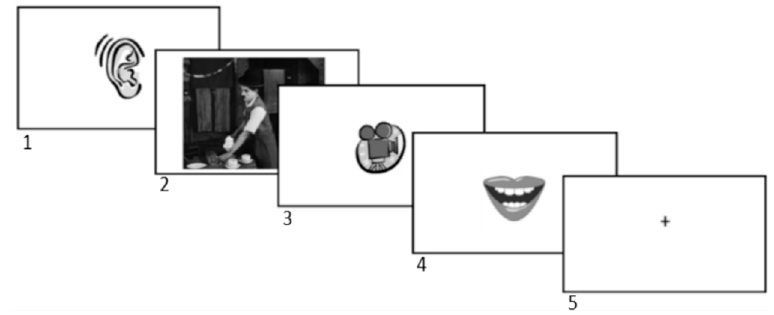
Figure 1. Example experimental trial of the memory loaded sentence repetition task in Halberstadt (2017) (used with the author’s